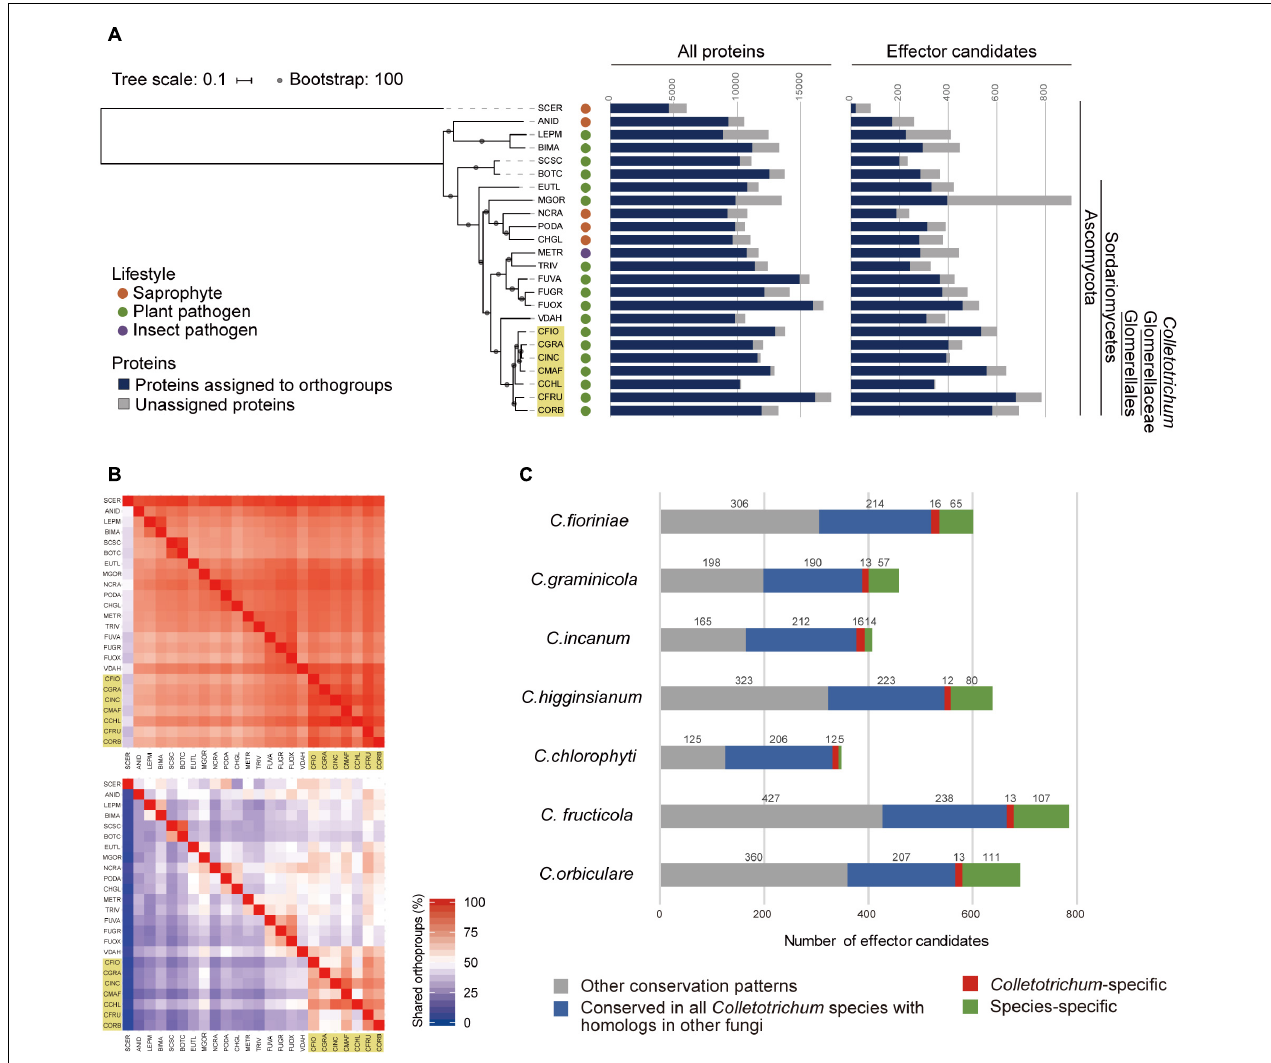
FIGURE 1 | Conservation patterns of the updated proteomes from 24 ascomycete fungi. (A) Number of proteins assigned to orthogroups. A maximum-likelihood species phylogeny was drawn based on the alignment of single-copy orthologs obtained using OrthoFinder. Bootstrap values are based on 1,000 replicates. The yellow box indicates Colletotrichum species. SCER: Saccharomyces cerevisiae , ANID: Aspergillus nidulans , LEPM: Leptosphaeria maculans , BIMA: Bipolaris maydis , SCSC: Sclerotinia sclerotiorum , BOTC: Botrytis cinerea , EUTL: Eutypa lata , MGOR: Magnaporthe oryzae , NCRA: Neurospora crassa , PODA: Podospora anserine , CHGL: Chaetomium globosum , METR: Metarhizium robertsii , TRIV: Trichoderma virens , FUVA: Fusarium vanettenii , FUGR: Fusarium graminearum , FUOX: Fusarium oxysporum f. sp. lycopersici , VDAH: Verticillium dahliae , CFIO: C. fioriniae , CGRA: C. graminicola , CINC: C. incanum , CMAF: C. higginsianum , CCHL: C. chlorophyti , CFRU: C. fructicola , and CORB: C. orbiculare . (B) Heatmap showing the percentage of orthogroups shared between each species pair. The upper panel shows the conservation of AP orthogroups and the lower panel shows the conservation of EC orthogroups. Each pair-wise percentage of shared orthogroups is calculated against the number of orthogroups in a species on the longitudinal axis. It is noted that panels are not mirrored because the number of orthogroups of each species differs. Colletotrichum species are highlighted with yellow boxes. (C) Conservation patterns of effector candidates from Colletotrichum species. The bar chart indicates the number of effector candidates in orthogroups by conservation